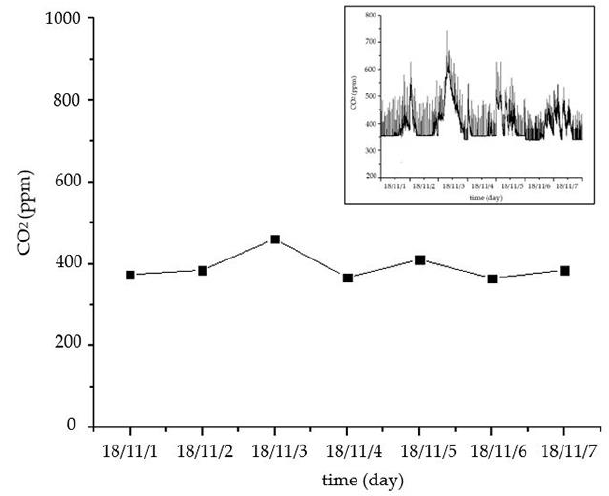
Figure 28. The curve of carbon dioxide concentration in a week.